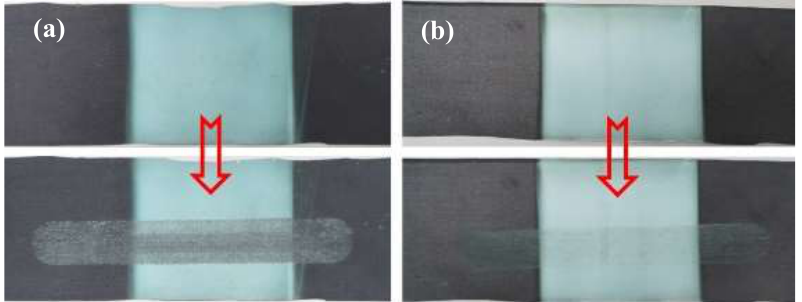
Figure 6 ． Photograph of SiO 2 ( a ) and SiO 2 /P(MMA-BA) ( b ) APSs before (up) and after (down) friction fastness test.